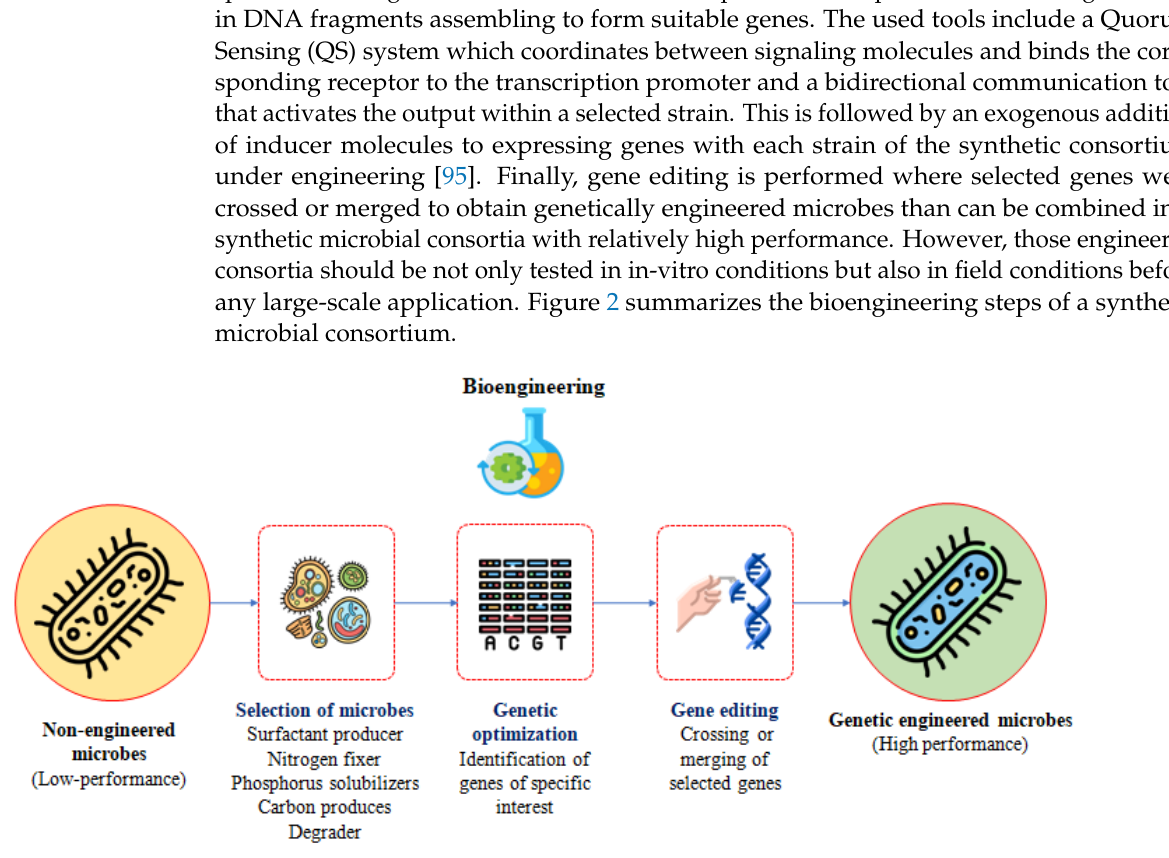
Figure 2. Bioengineering steps of synthetic microbial consortium.